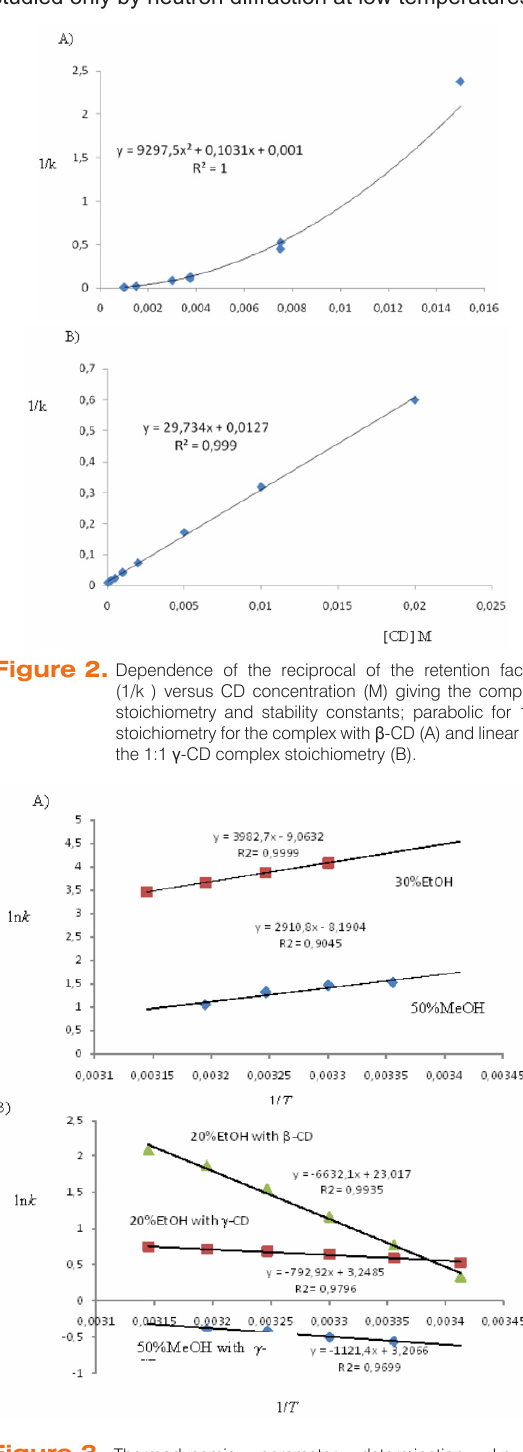
Figure 3. Thermodynamic parameter determination: Ln k of cyclophane as a function of 1/T (A) without cyclodextrin, (B) with